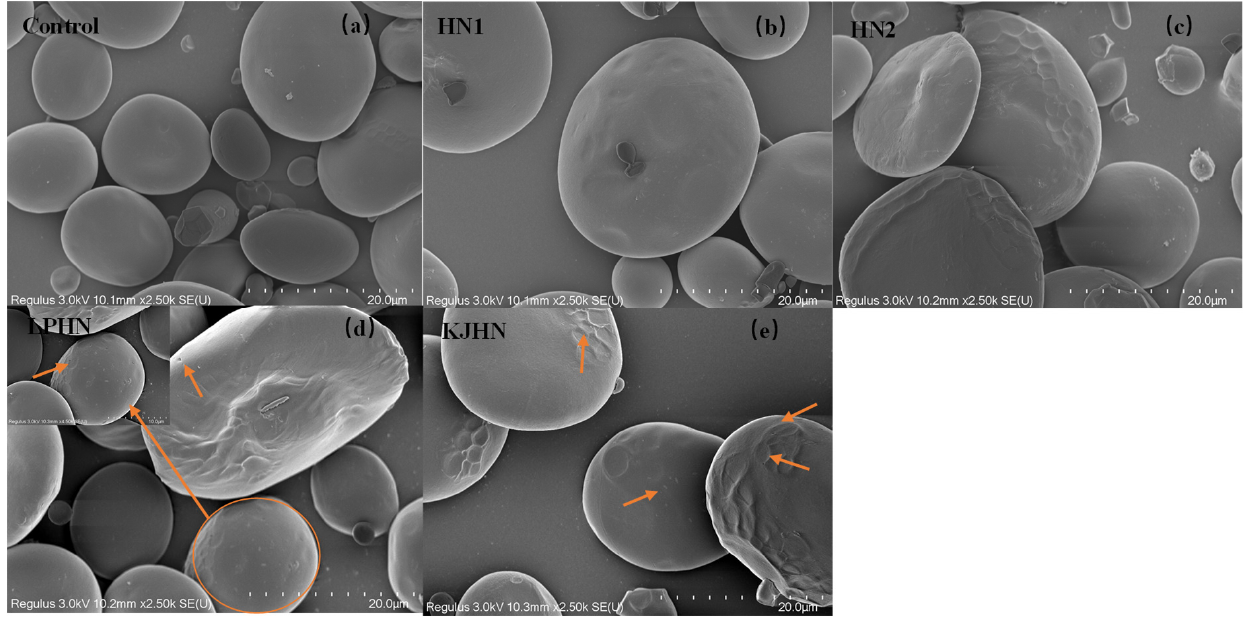
Figure 3. Scanning electron micrographs of starch. ( a ) Control, unfermented noodles; ( b ) HN1, hollow noodles 1; ( c ) HN2, hollow noodles 2; ( d ) LPHN, Lactobacillus plantarum -fermented hollow noodles; KJHN, ( e ) Koji-fermented hollow noodles.